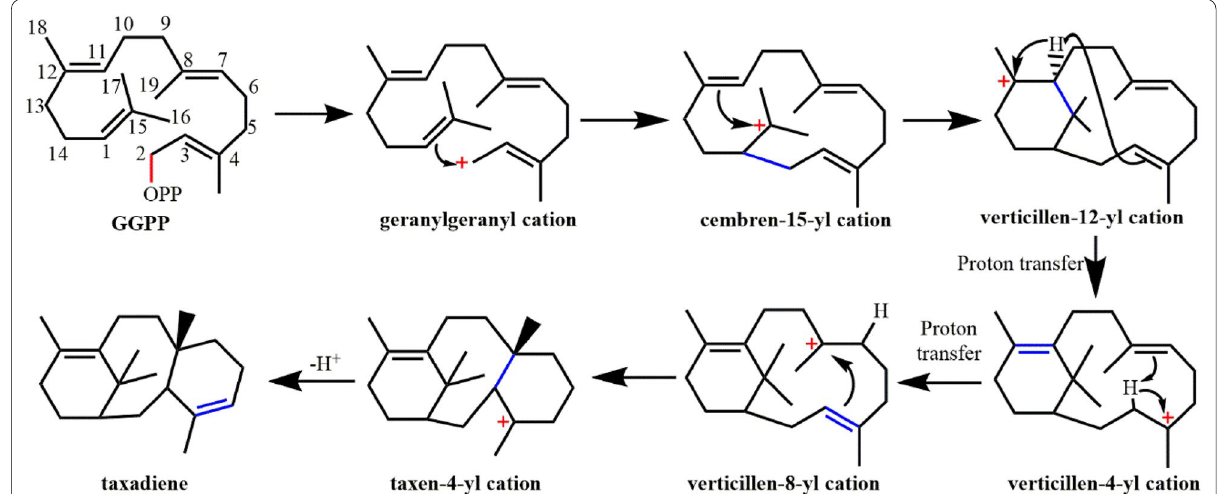
Fig. 13 Formation of taxadiene from geranylgeranyl pyrophosphate (GGPP) by taxadiene synthase